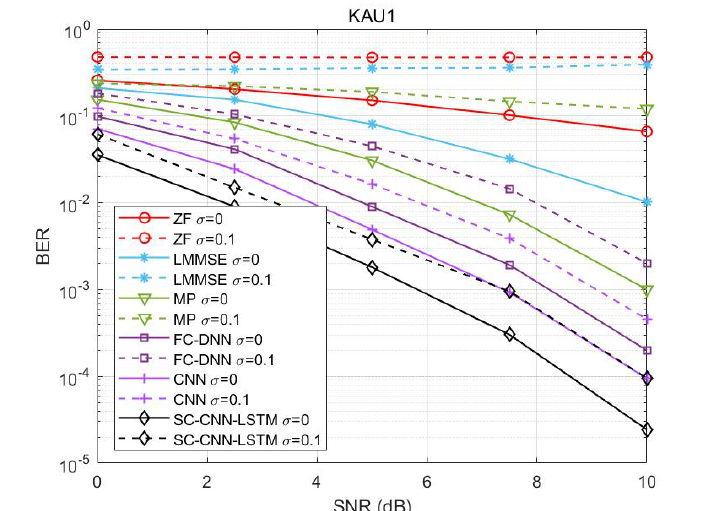
Figure 13. BER performance comparison under non-ideal channel estimation for KAU1 experiment.